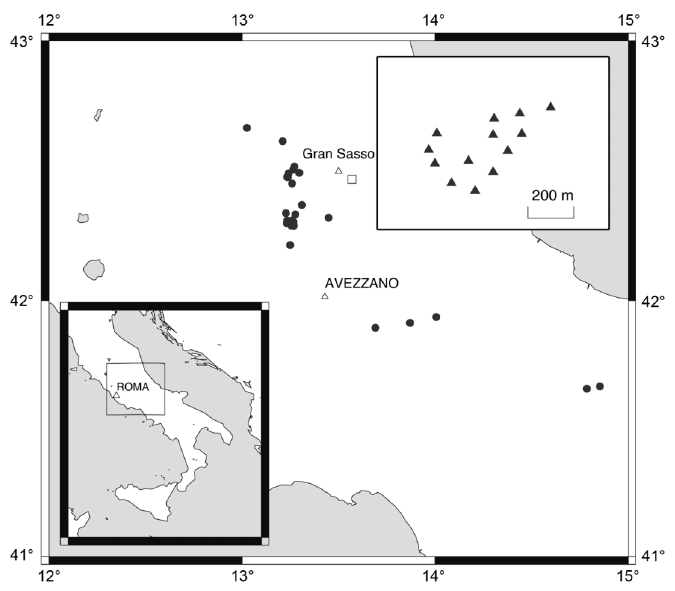
Fig. 1. Map of Central Italy with location of the Gran Sasso INFN laboratories (square) and epicenters of the analysed earthquakes (black dots). Sites mentioned in the text are labeled. The inset at the upper rigth shows the configuration of the UNDERSEIS seismic